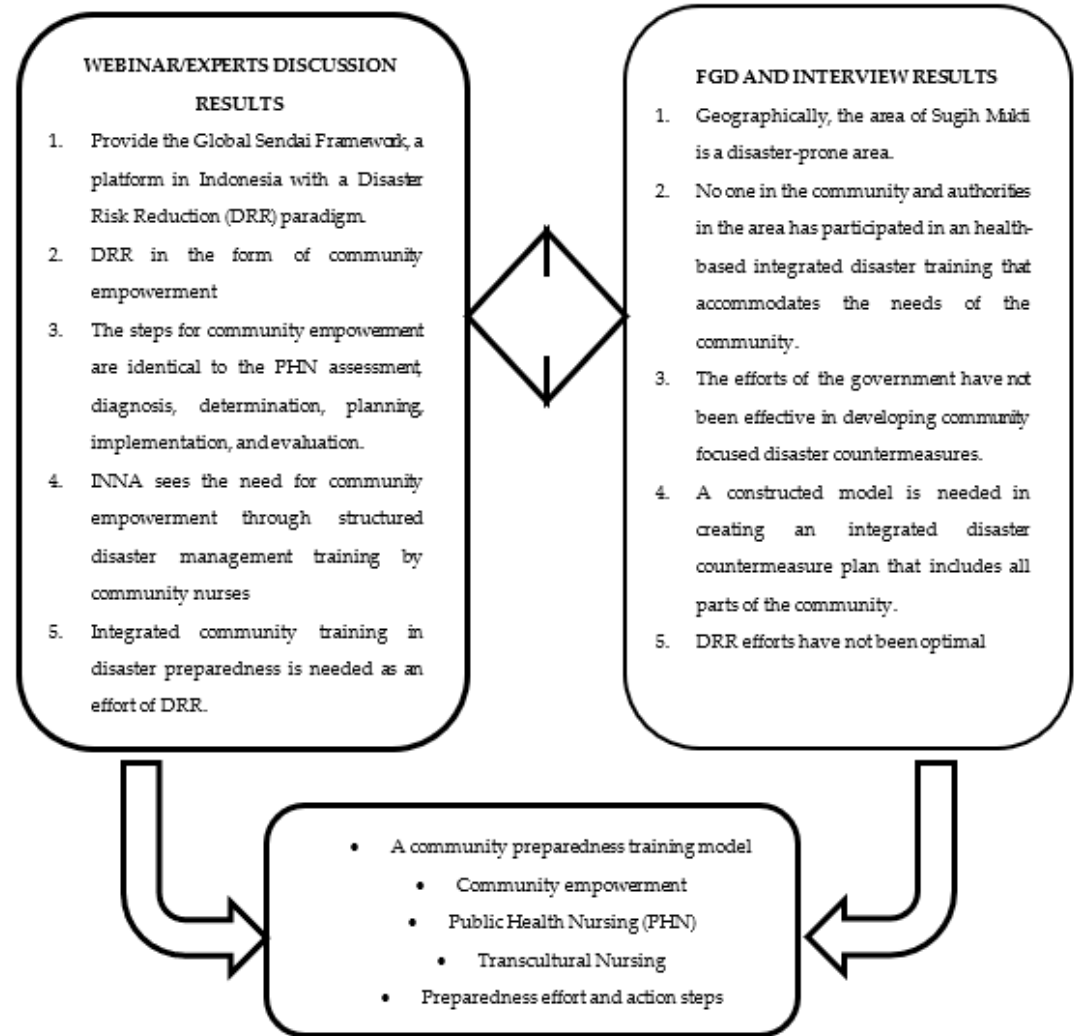
Figure 1. Thematic description of Disaster Risk Reduction (DRR) needs in community nursing.